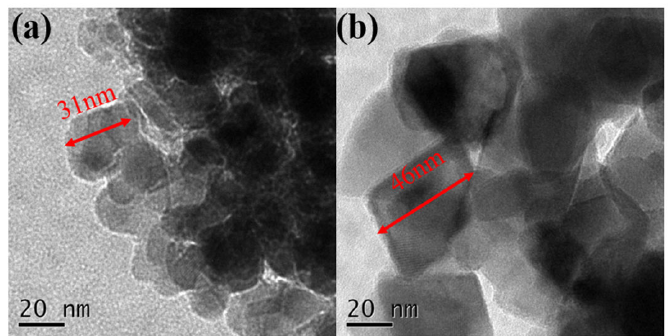
Figure 4. TEM images of naked MnFe 2 O 4 ( a ) and MnFe 2 O 4 @chitosan ( b ).